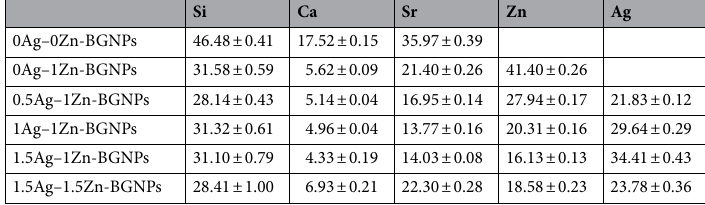
Table 2. Elemental compositions of BGNPs